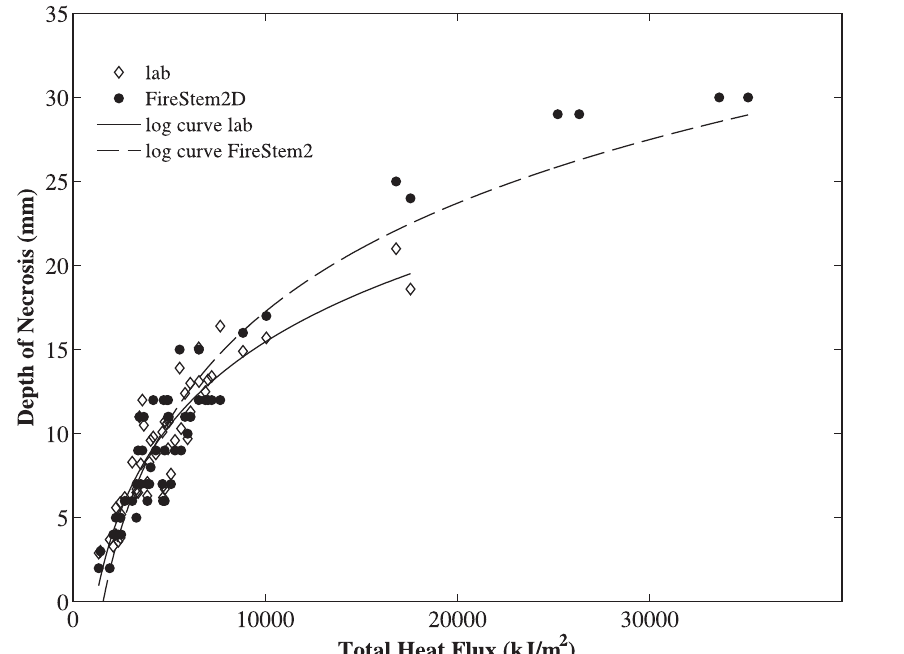
Figure 7. Depth of necrosis (mm) (y-axis) versus the measured total-energy flux integrated over time, THF in kJ/m 2 (x-axis), for all stem sections used in the lab experiments. Dashed line marks a logarithmic fit of simulation results (y=21.48( 6 1.89)log(x) 2 68.66( 6 7), R 2 =0.93 ), solid line marks a logarithmic fit of observed laboratory results (y=16.63( 6 2.1)log(x) 2 51.05( 6 7.63), R 2 =0.84 ). This model-driven empirical relationship can be used to extrapolate stem heating and vascular cambium necrosis beyond heat fluxes used in experimental stem heating trials.